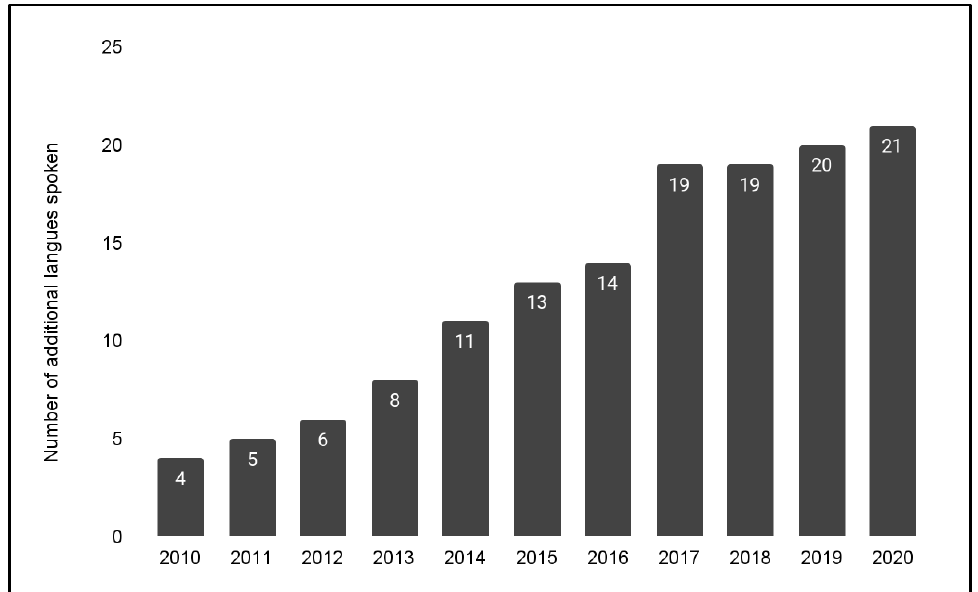
Figure 4. Additional languages (not English or Spanish) spoken by patients and family. The number of additional languages spoken has increased over time from a total of n = 4 in 2010 to a total of n = 20 in 2020, mainly among Black or Asian patients.